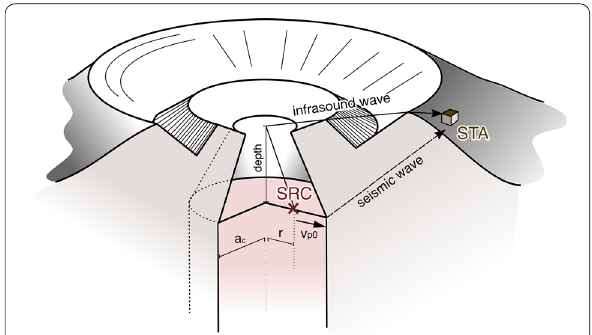
Fig. 6 Schematic model of the shallow conduit of Aso volcano. Inside the active vent, a lava pond exists. The space above its magma–air interface is the shape of a frustum pipe and acts as a resonant pipe. The radius of the closed end of the frustum pipe a c is identical to that of the lava pond. Strombolian explosions occur at the surface of the lava pond. At the time of an explosion, seismic and infrasound signals are generated simultaneously at the source of explosion (SRC). The seismic signal propagates through the lava pond at a velocity of v p0 and then propagates toward the station STA from the margin of the lava pond at P-wave velocity. The infrasound signal propagates through the air. The source position is expressed by a distance r from the center of the lava pond. We assumed that the sources are distributed across the entire surface of the lava pond (( 0 ≤ r ≤ a c